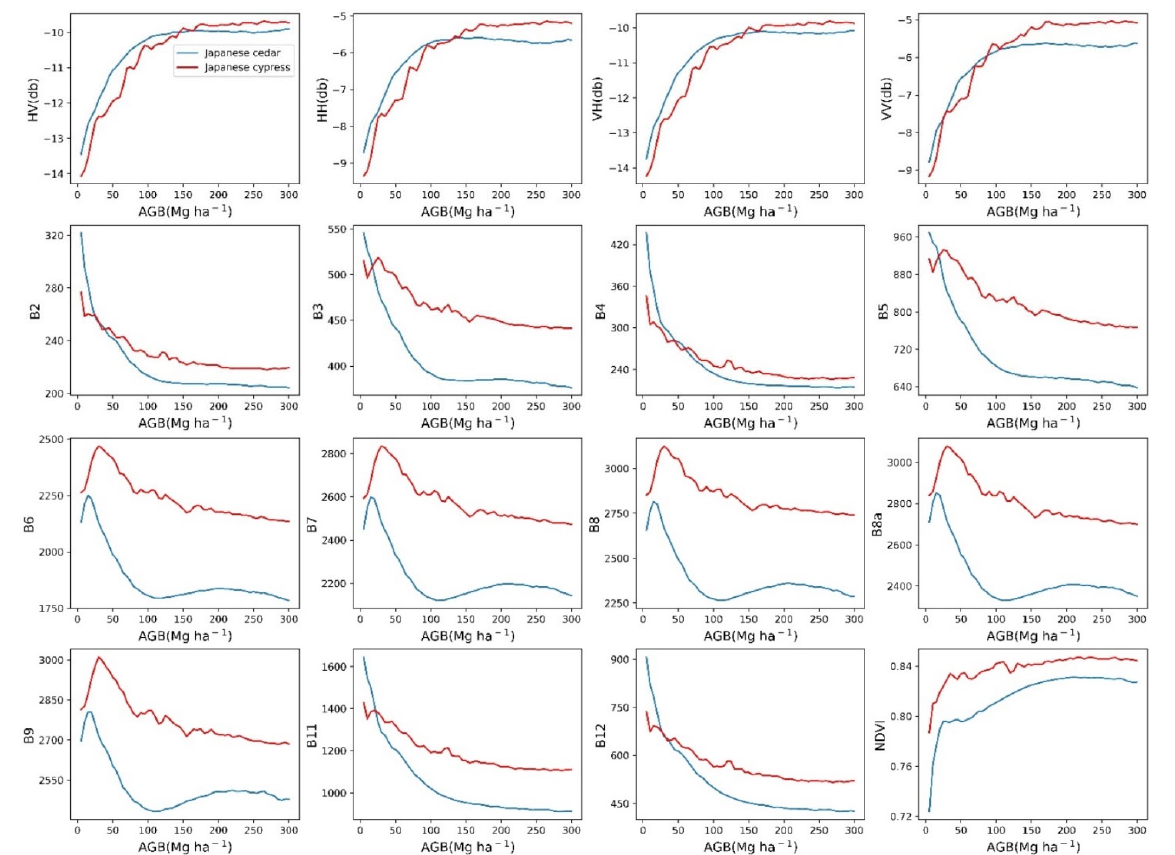
Figure 9. Relationships between aboveground biomass (AGB) and satellite image data of Japanese cedar and Japanese cypress using averages of bins with a width of 5 Mg ha − 1 . Sensor variables are defined in Tables 3 and 4.